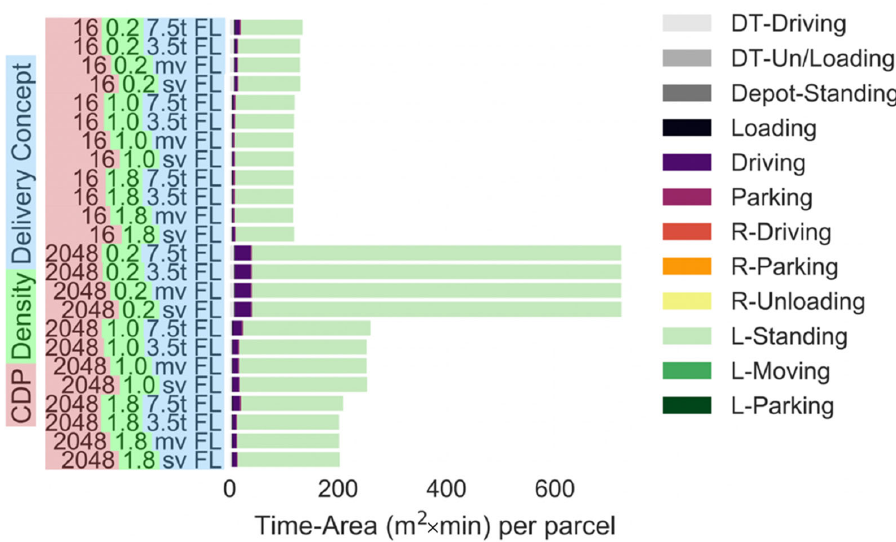
Figure 7. Time ‐ area requirements of delivery to fixed lockers assuming various maximum delivery vehicle sizes (number of CDPs: 16 or 2048). Parcel demand level: 0.2: 20% of the current demand, 1.0: current demand, 1.8: 80% increase in the demand. (Note: All parts apart from driving and L-Standing are negligibly small.)